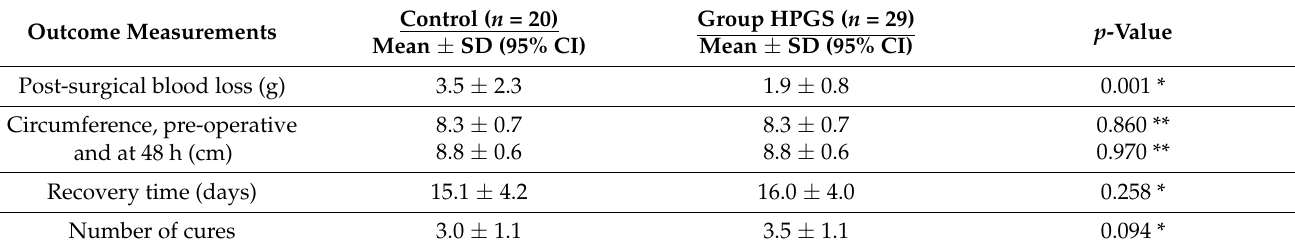
Table 4. Comparison of the outcome between the control group and the experimental Group C. Table 5. Recurrencein relation to the number of procedures performed.